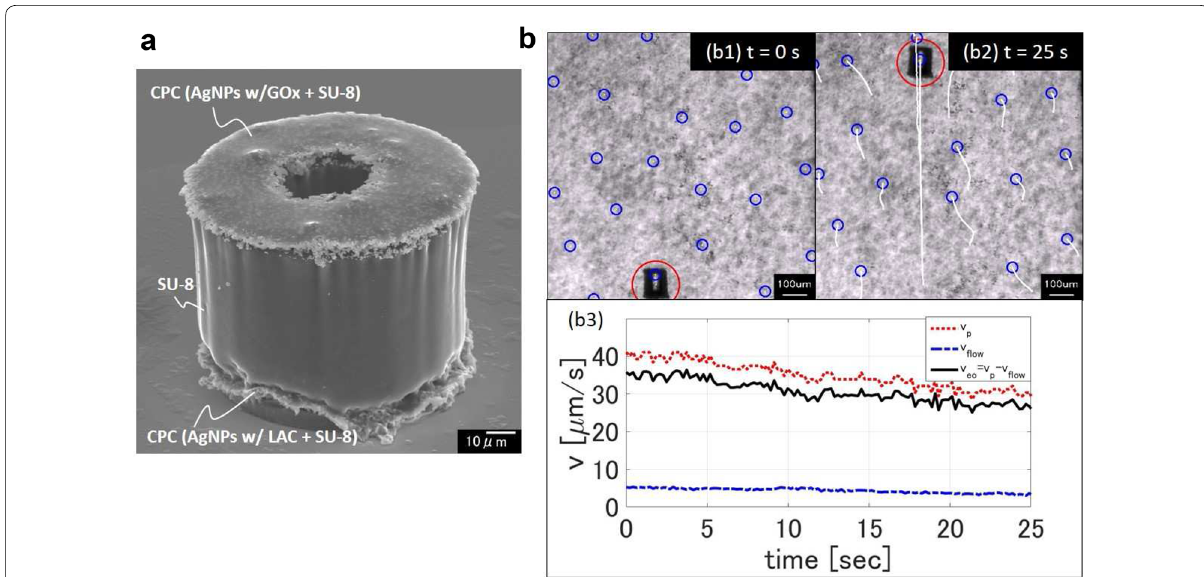
Fig. 5 Results of 100 μm prototypes [11]. a SEM image of the 100 μm prototype fabricated by the standard photolithography. b Self-propulsion of the fastest 100 μm prototype in a glucose solution. (b1), (b2) Snapshots extracted from a video. A red circle, blue circles, and white curves added by “OpenCV” represent the center of gravity (CG) of the prototype, surrounding particles indicating convective flows, and their trajectories, respectively. (b3) Velocities against time t extracted from the video with the sampling interval of 0.1 s, where v p is the velocity of the CG of the prototype, v flow the mean velocity of the surrounding convective flows in the same direction, and v p − v flow the identified self-propulsion velocity v eo